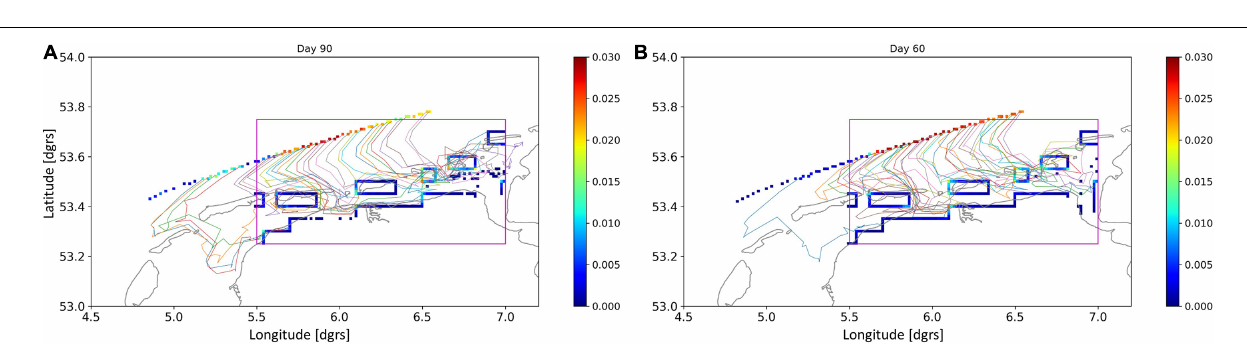
FIGURE 7 | Results of reconstruction of the most likely release areas of HDPE pellets. The relative density of particles (fraction of the total number of particles released per 1 × 1 km rectangle) that arrived in the magenta rectangle is shown. Also shown is the relative density of the same particles (fraction of the total number of particles released per 1 × 1 km rectangle) at their starting positions along the trajectory of MSC Zoe. In addition, the tracks of a subset of these particles is show. The gray line is the the coast line. With a vertical velocity of 0.06 ms − 1 and: (A) a horizontal diffusion coefficient of 0.5 m 2 s − 1 , (B) a horizontal diffusion coefficient of 12 m 2 s − 1